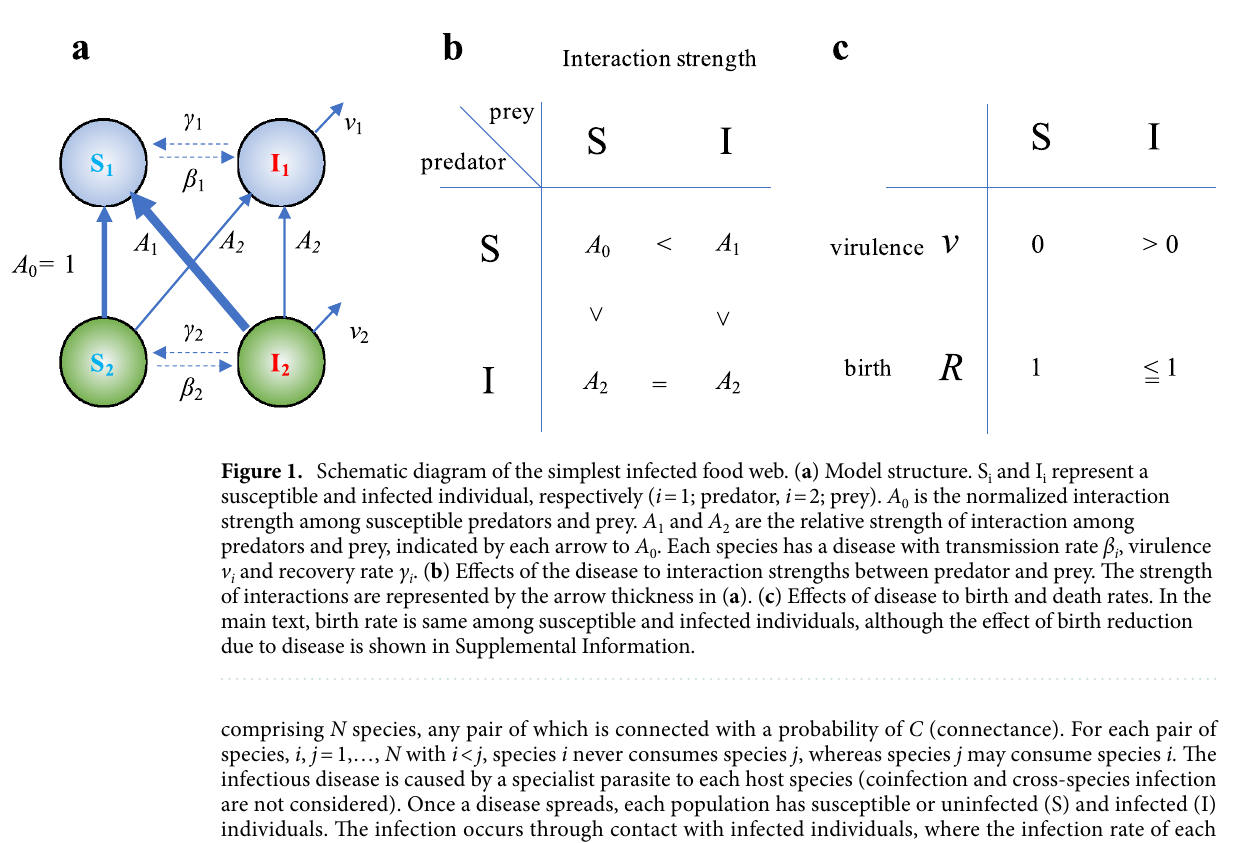
comprising N species, any pair of which is connected with a probability of C (connectance). For each pair of species, i , j = 1,…, N with i < j , species i never consumes species j , whereas species j may consume species i. The infectious disease is caused by a specialist parasite to each host species (coinfection and cross-species infection are not considered). Once a disease spreads, each population has susceptible or uninfected (S) and infected (I) individuals. The infection occurs through contact with infected individuals, where the infection rate of each species is notated by β i , and infected individuals recover at a constant rate γ i into susceptible individuals. The parasites do not increase through vertical transmission. The infected individuals have a higher death rate than susceptible individuals; the additional death rate is defined as virulence, notated by v i . Population dynamics are driven by interspecific predator–prey interactions and host-parasite interactions via the infectious disease (see Methods). The interaction strength is a key factor affecting the food web dynamics. Here, I consider that the